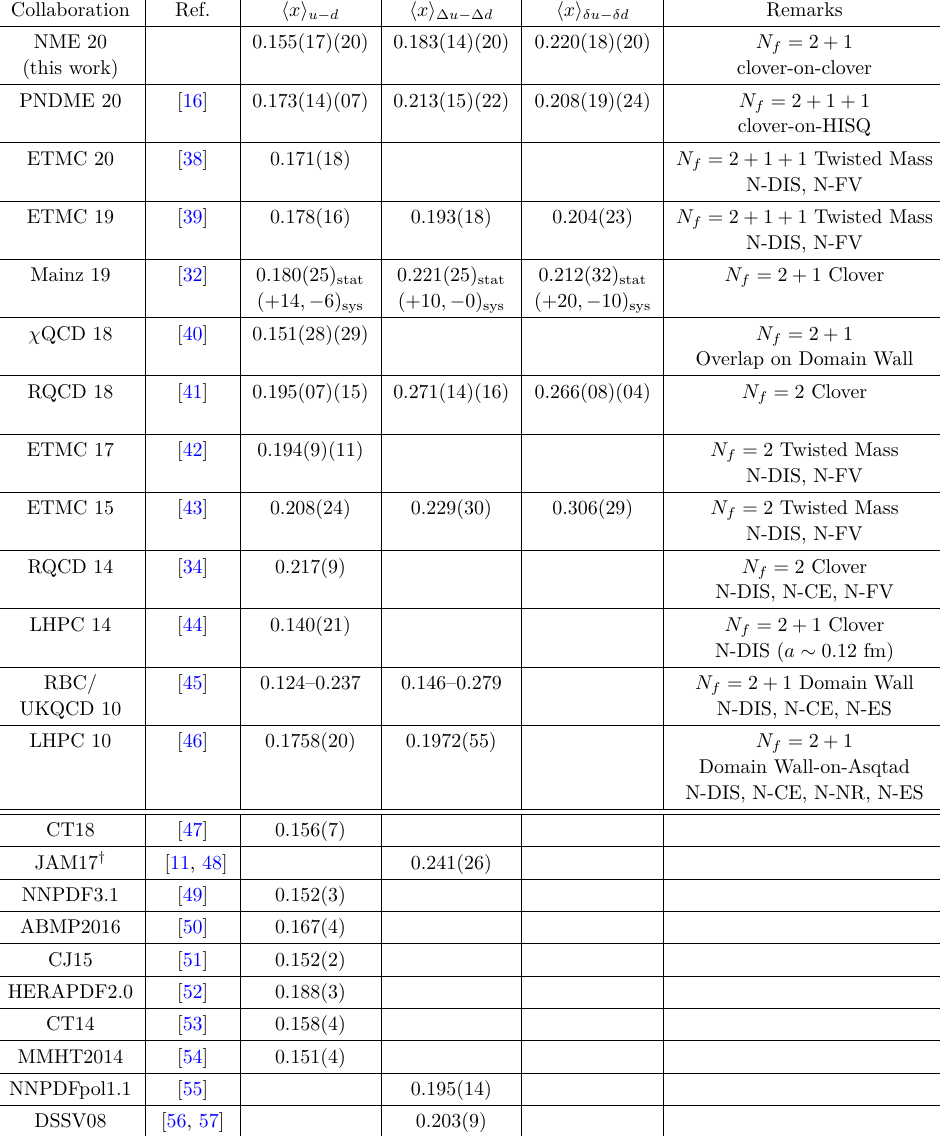
Table 5 . Our lattice QCD results are compared with other lattice calculations with N f flavors of dynamical fermions in rows 2–13, and with results from phenomenological global fits in the re- mainder of the table. In both cases, the results are arranged in reverse chronological order.